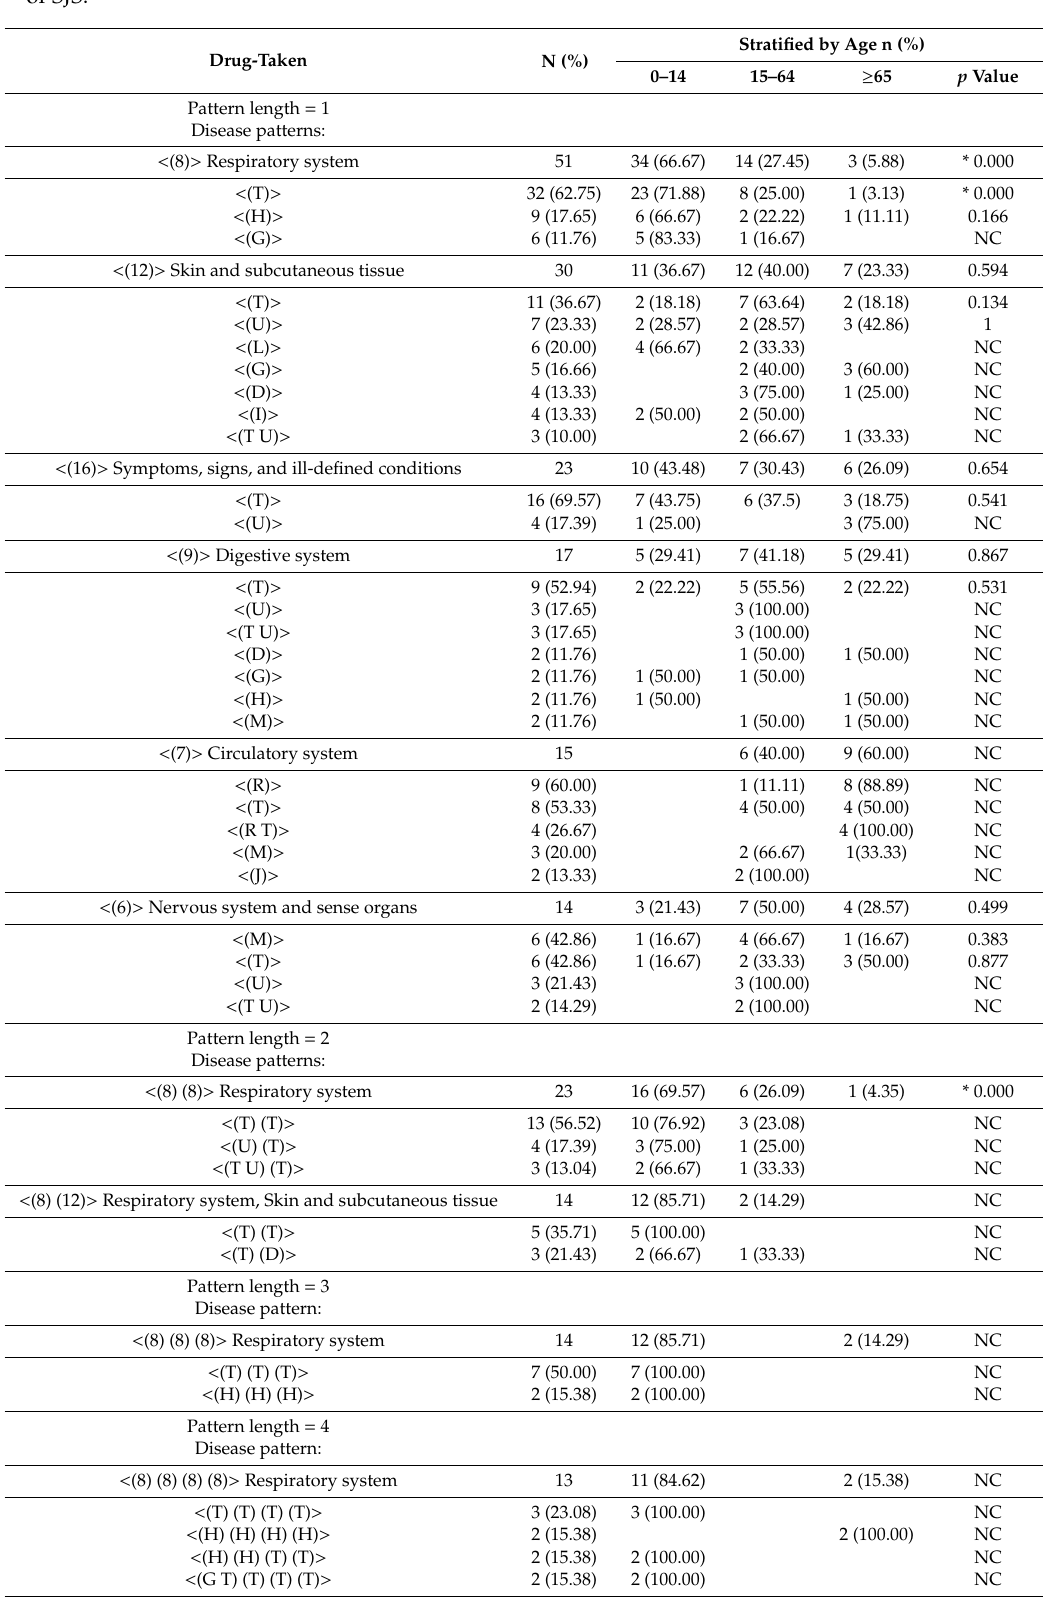
Table 8. The mined disease sequential patterns of medications prescribed before the development of